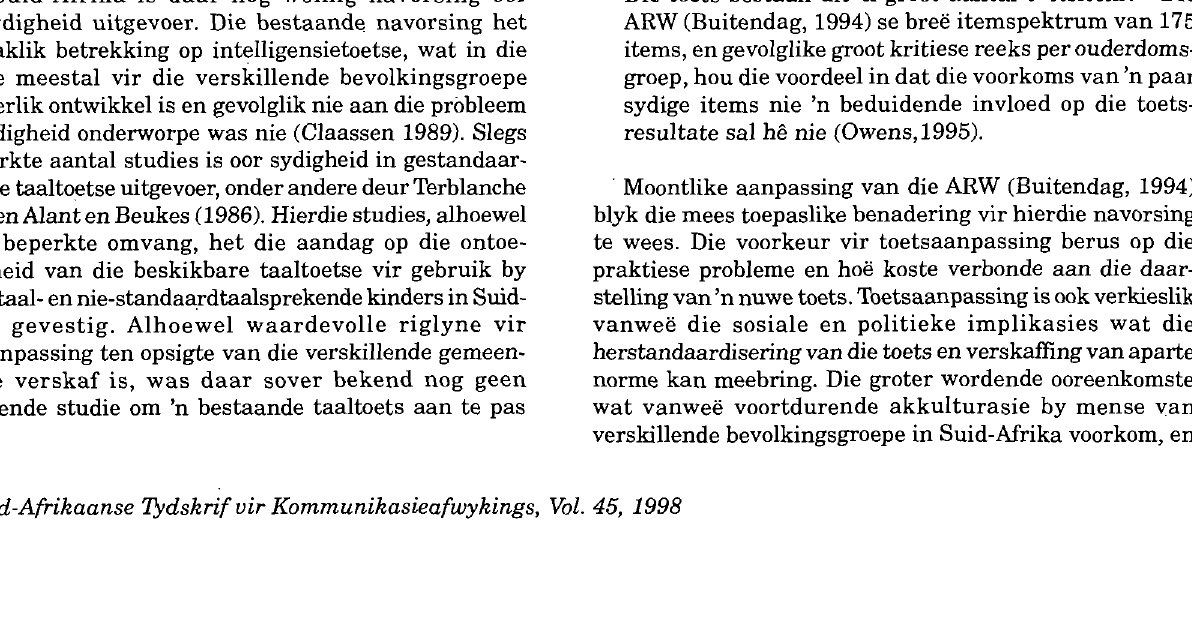
ffektiewe instrumente vir die identifisering van ;:a~fwykings by verskillende groepe te voorsien (Stock- man,